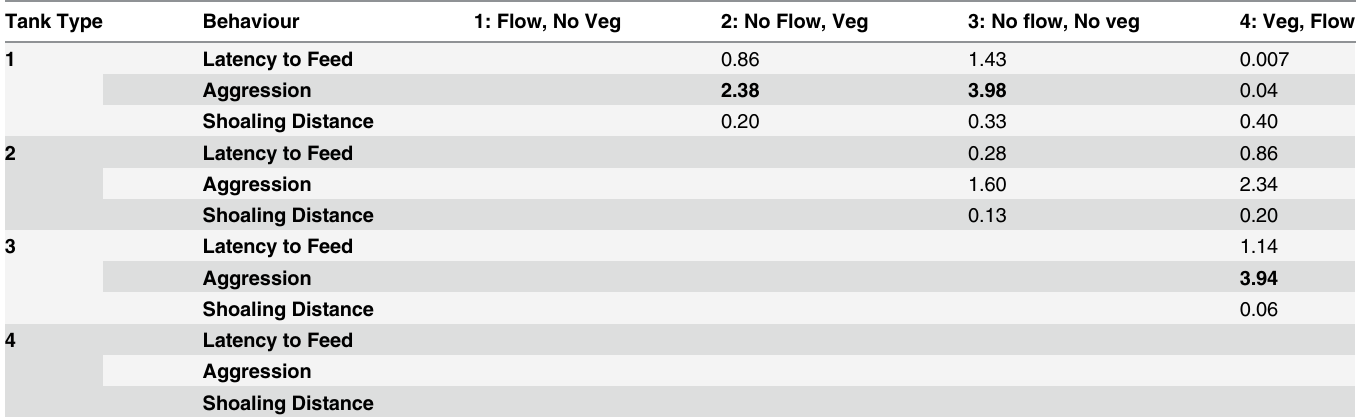
Table 3. Paired comparisons of mean differences across tank treatment types (1, 2, 3 and 4) for (log transformed) Latency to feed, (square-root transformed) Aggression and (log transformed) Shoaling distance measurements. Tank Type